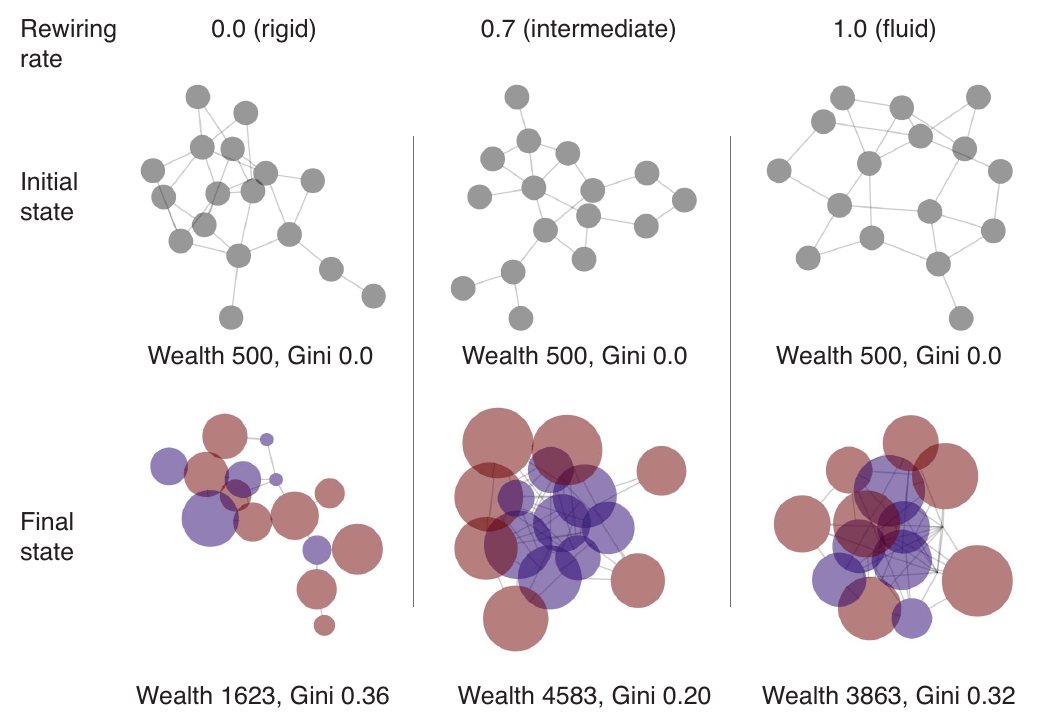
Figure 1: Examples of the results in experimental human social networks. The initial state (before the first round) and the final state (after the final round) in three out of 90 sessions are shown. For simplicity, we display typical results from three conditions of experimentally specified rewiring rates, which represent the level of network fluidity drawn from the full range of rewiring rates (0.0–1.0). Node size indicates wealth in monetary units (nodes with larger area are richer). Therefore, larger differences in node sizes in one network graph imply the existence of a larger wealth inequality. Node color indicates the cooperation behavior at the last round (blue: cooperate, red: defect, and grey: no history). “Wealth” represents the average wealth of all the subjects. “Gini” represents the Gini coefficient (the indicator for the level of wealth inequality among all the subjects) The (small) difference in the number of nodes between the initial and the final states comes from subject drop-outs across the